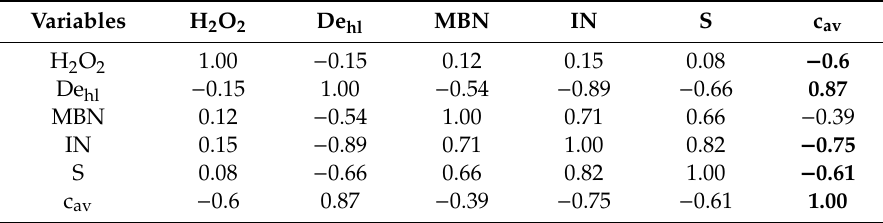
Bolded text—statistically significant correlations; c av —average dye